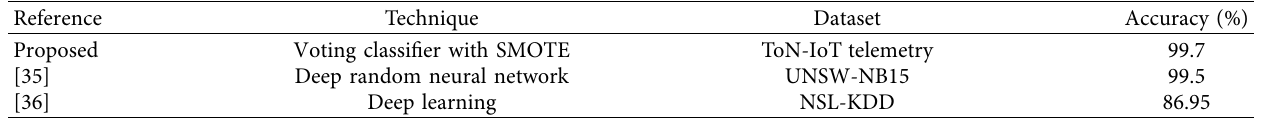
Table 8: Results comparisons in state of the art on public